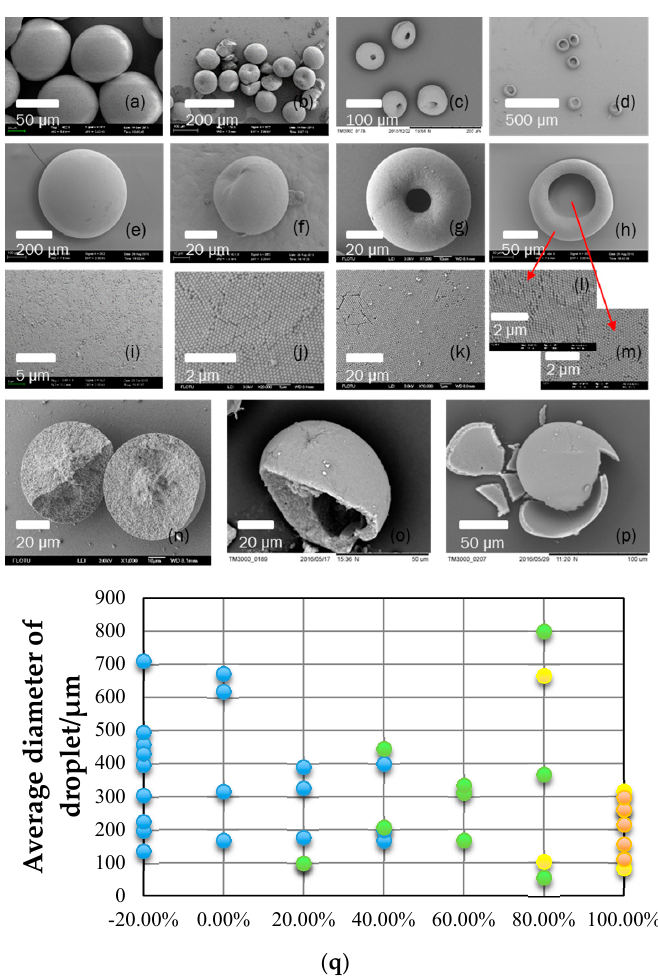
Figure 3. ( a – d ) SEM images of many photonic crystal particles with the same shape. ( e – h ) SEM images of photonic crystal particles with different shapes, including spheres, stomatocytes, toroidals and pies. ( i – m ) Partial surface of photonic crystal particles ( e – h ) respectively. ( n – p ) The internal structures of photonic crystal particles. Photonic crystal spheres ( a , e ) were extracted by 1-octanol including 20 wt.% octane, photonic crystal particles like stomatocytes ( b , f ) were extracted by 1-octanol including 20 wt.% n-Butanol, photonic crystal toroidals ( c , g ) were extracted by 1-octanol including 80 wt.% n-Butanol, photonic crystal particles like pies ( d , h ) were extracted by n-Butanol. ( q ) The relationship between the shape of photonic crystal particles and the size of droplet, the composition of extractant. Blue dots represent that shapes of particles are spheres; green dots represent stomatocytes; yellow dots represent toroidals; orange dots represent pies. Horizontal axis means the percentage of n-Butanol in extractant, and − 20.00% means extractant is 1-octanol including 20 wt.% octane, 0.00% means extractant is 1-octanol.